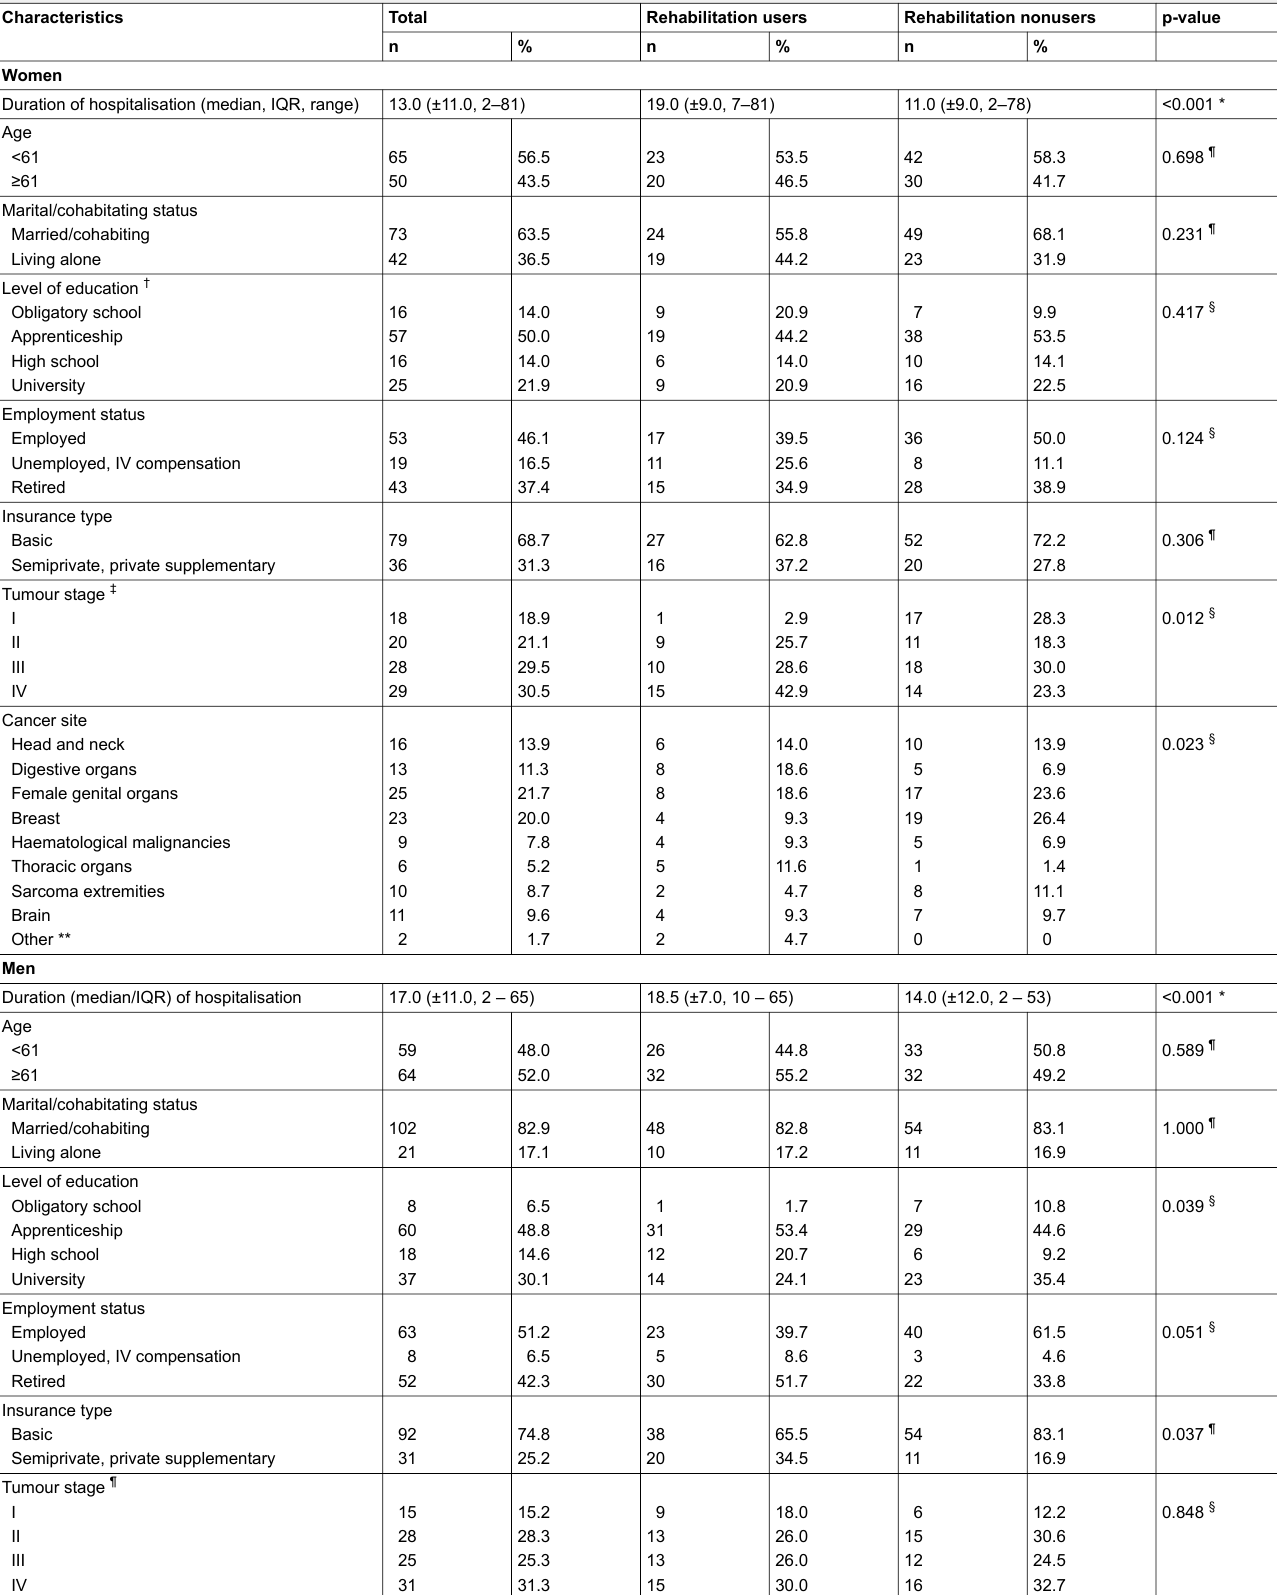
Table 3: Characteristics for women and men with regard to use of inpatient